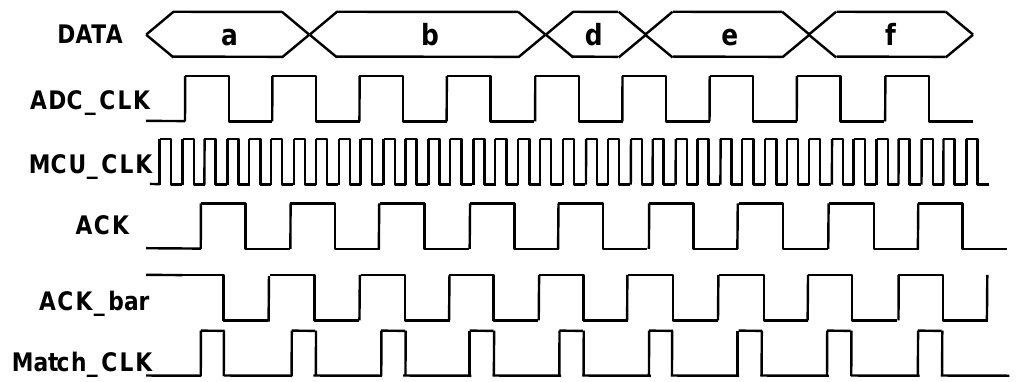
Figure 6. Example of handshake between asynchronous